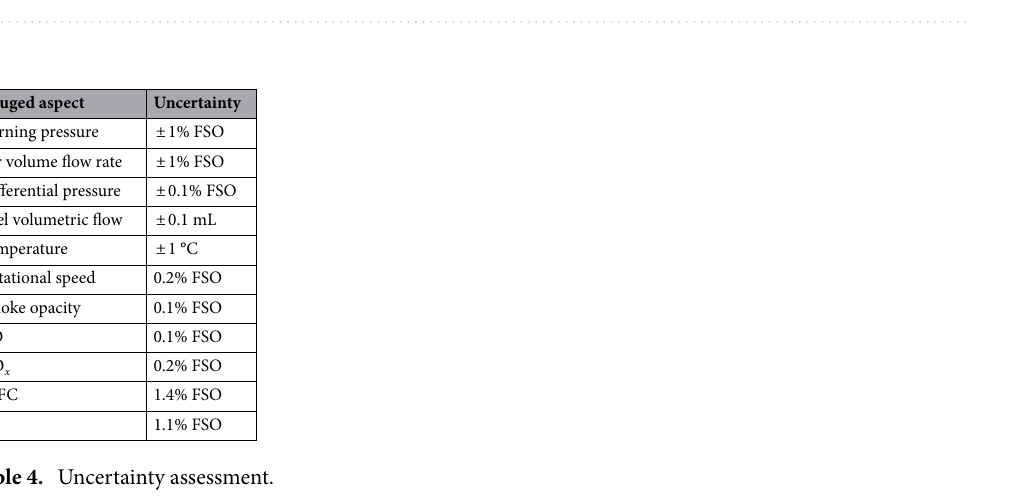
Figure 4. TGA assessment for evaluated fuels.